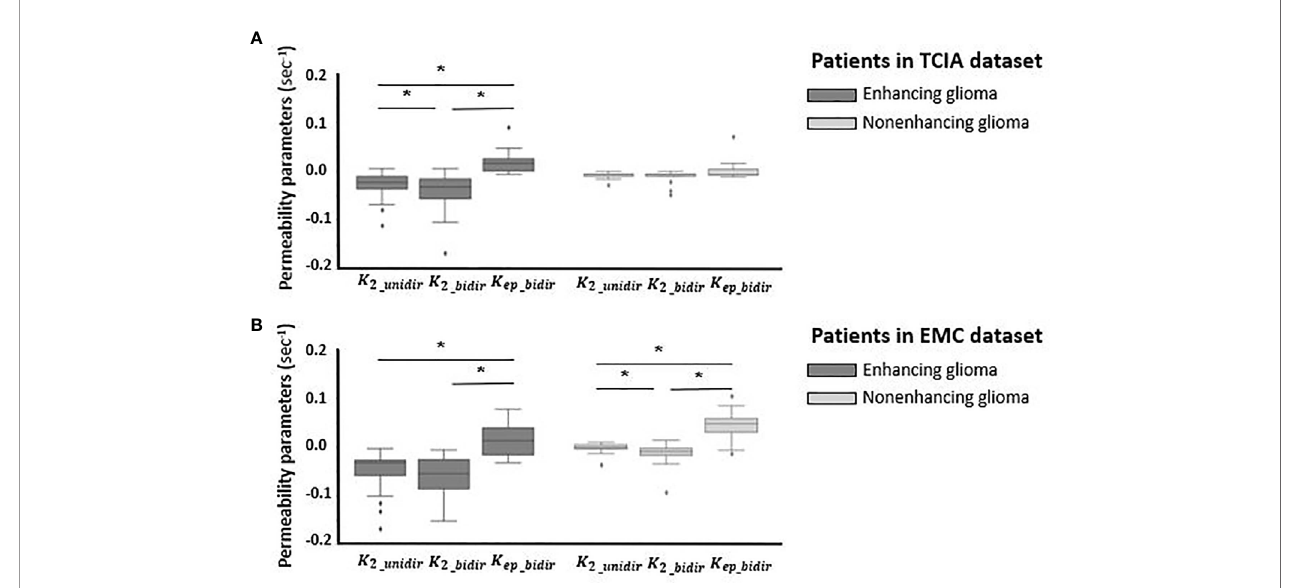
FIGURE 5 | Boxplots of permeability parameters of K 2 in unidirectional correction method and K 2 and K ep in bidirectional correction method from left to right (A) for enhancing glioma (n = 35) (dark gray) and for nonenhancing glioma (n = 14) (light gray) in TCIA dataset; (B) for enhancing glioma (n = 20) (dark gray) and nonenhancing glioma (n = 27) (light gray) in EMC dataset. *Signi fi cantly different, p < 0.05.